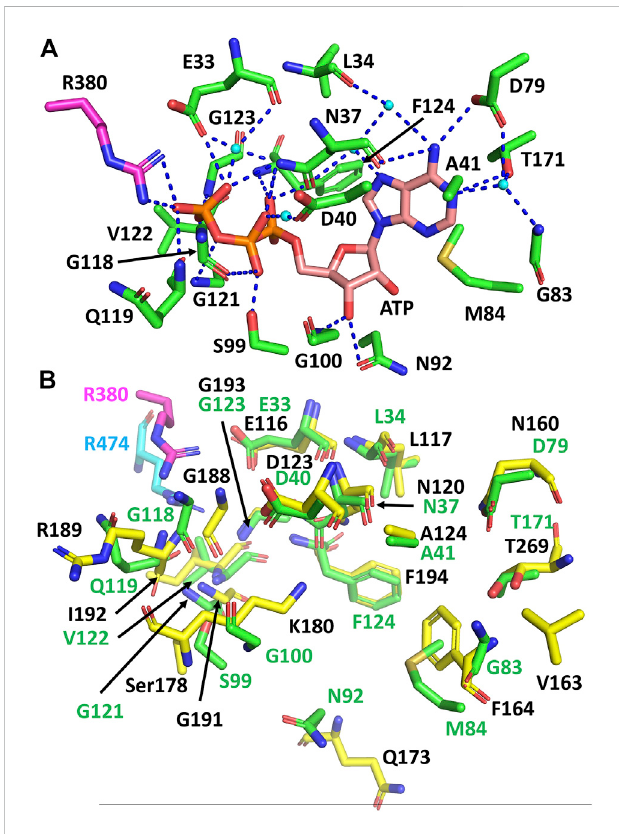
FIGURE 3 ComparisonoftheresiduesrequiredforATPbindingandhydrolysis by Hsp90 and sacsin. (A) PyMOL cartoon of the yeast Hsp90 residues involved in the binding and hydrolysis of ATP. Residues are in stick conformation. The putative catalytic Arg 380 of Hsp90 is coloured in magenta. Water molecules are shown as cyan coloured spheres and hydrogen bond interactions as dashed blue lines. Potentially, these may also be conserved in sacsin, since the side chain environment around them is similar. (B) PyMol cartoon showing the superimposition of Hsp90 residues involved in the binding and hydrolysis of ATP and the corresponding sacsin residues. Green stick residues with green numbering, Hsp90 residues with the catalytic Arg 380 in magenta. Yellow stick residues with black numbering, sacsin residues with the catalytic Arg 474 shown in